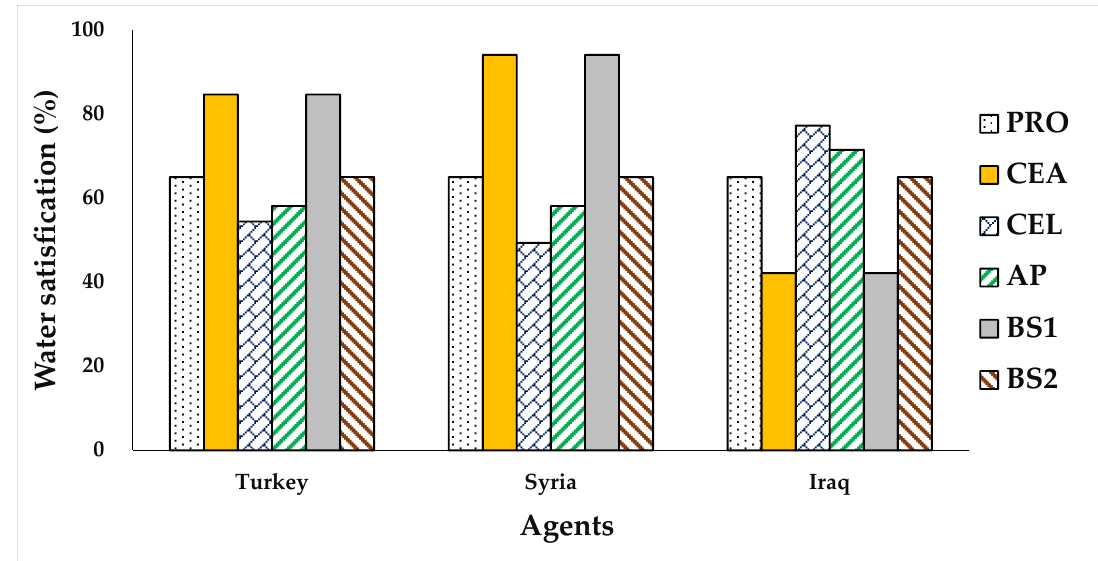
Figure 2. Water satisfactions (%) of three agents under four classical bankruptcy solutions and two Nash bargaining solutions. BS1: bargaining solution under d i = 0 and ω i = 1; BS2: bargaining solution under d i = 0 and ω i = ω Rc. ; PRO: proportional; CEA: constrained equal award; CEL: constrained equal loss; AP: adjusted proportional.